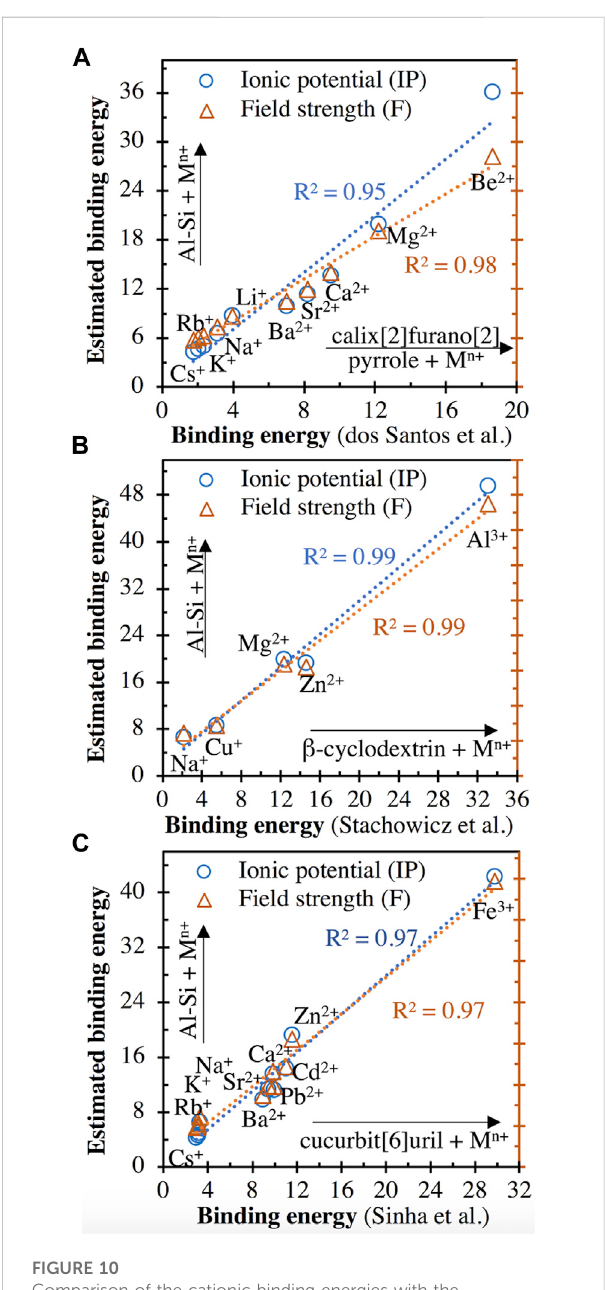
FIGURE 10 Comparison of the cationic binding energies with the aluminosilicate dimer ([(OH) 3 -Si-O-Al-(OH) 3 ] − 1 ) estimated using Eqs. 3, 4 and the DFT-derived binding energies of same cations interacting with three organic species: (A) calix[2]furano[2]pyrrole (C 20 N 2 O 2 H 9 ) (Teixeira dos Santos and Magalhães, 2010), (B) β - cyclodextrin (C 42 H 70 O 35 ) (Stachowicz et al., 2011) and (C) cucurbit[6] uril (C 36 H 36 N 24 O 12 ) (Sinha and Sundararajan, 2014). All energies are in units of eV. The range of cation types studied in each of the three literature studies is provided, along with the R 2 values achieved for linear